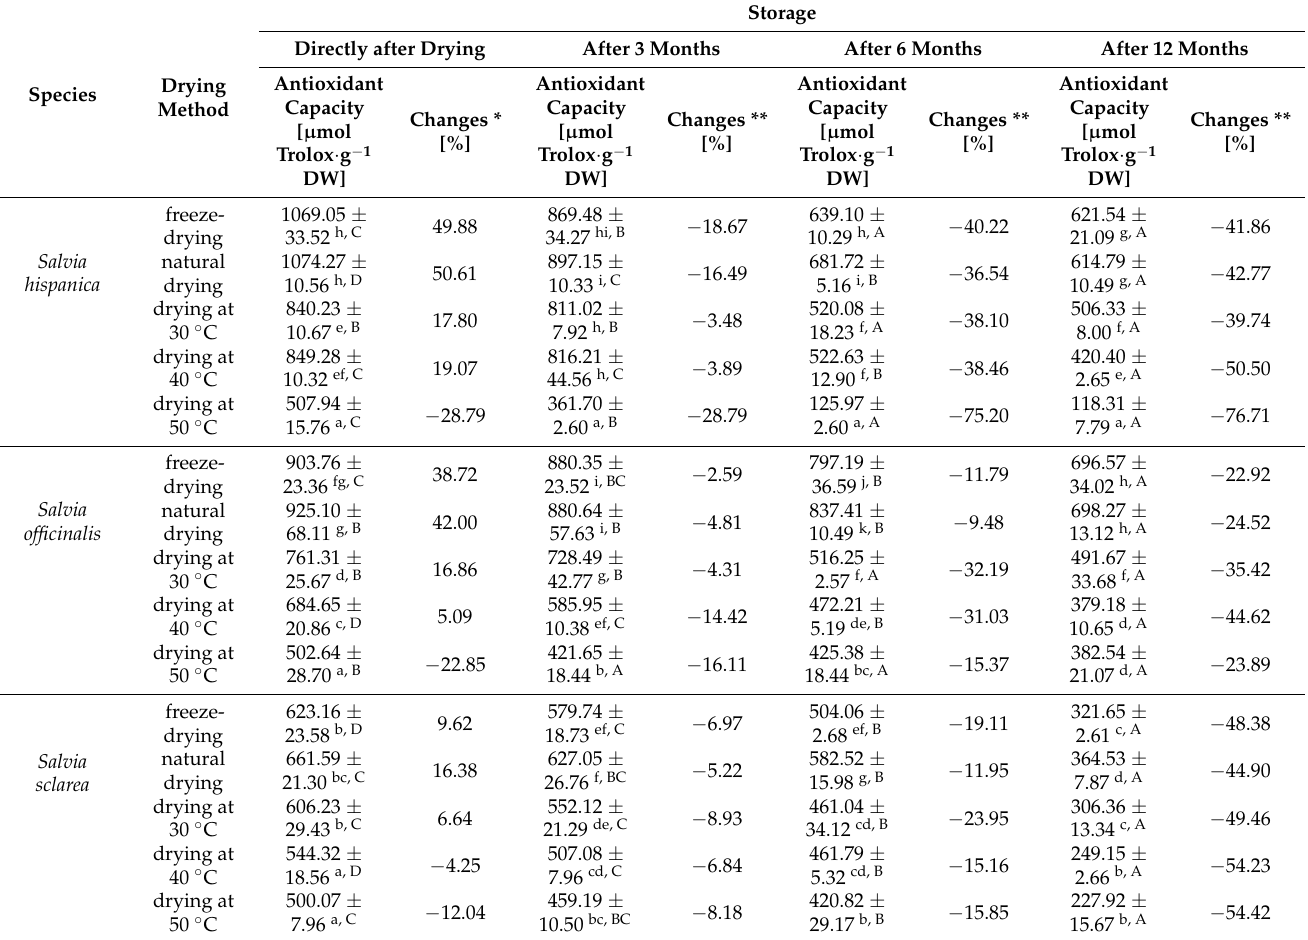
Table 8. The antioxidant activity in dried and stored sage of individual